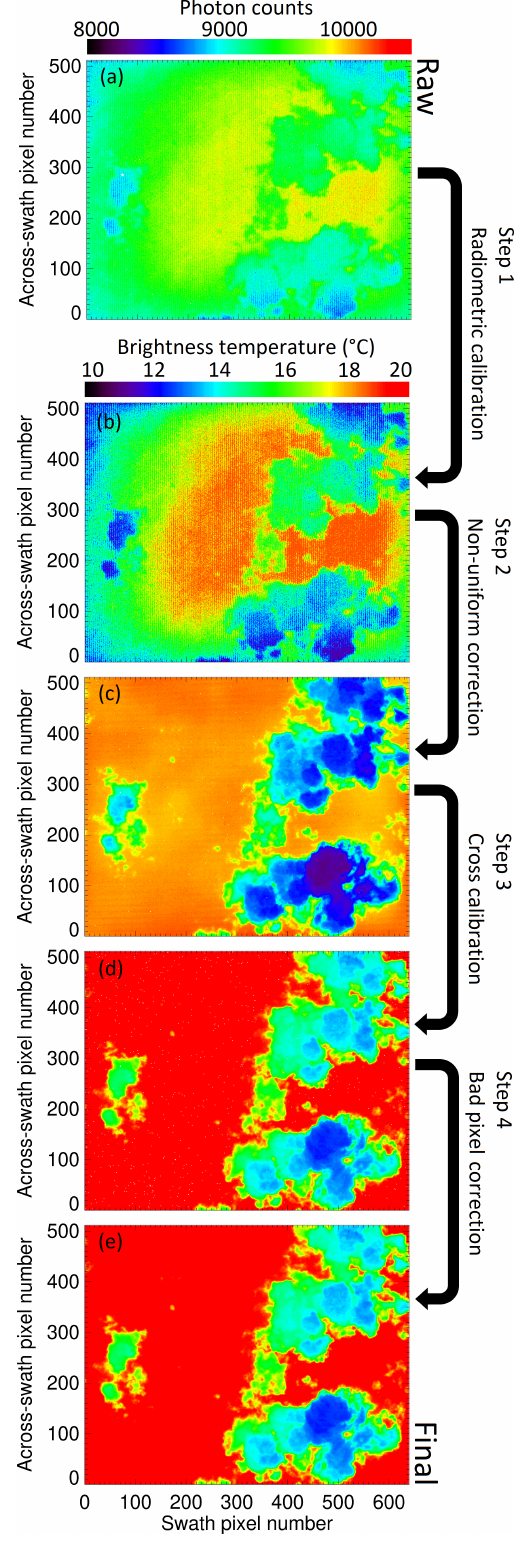
Figure 2. Illustration of the post-processing steps using a 2D VELOX image acquired with the broadband channel (7.7–12µm) during the EUREC 4 A flight on 13 February 2020 at